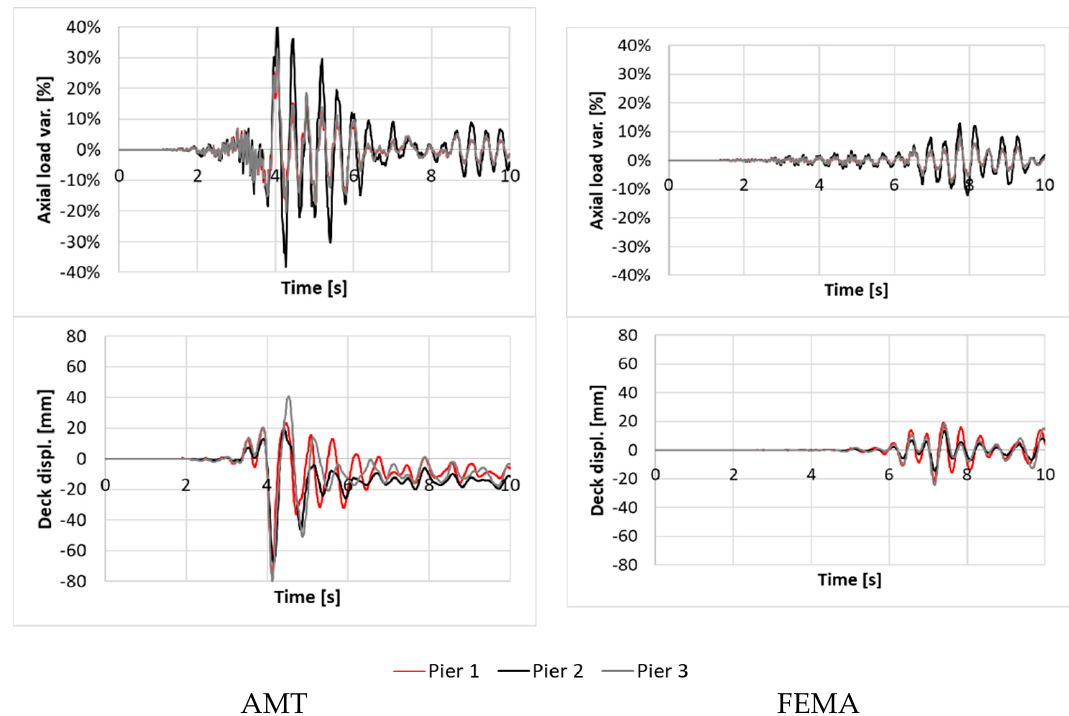
Figure 7. NRHA with scale factor 1.0 (considering both vertical and transversal components: top). Variation of the axial load (from the static load on piers during the seismic event; bottom). Deck displacements.